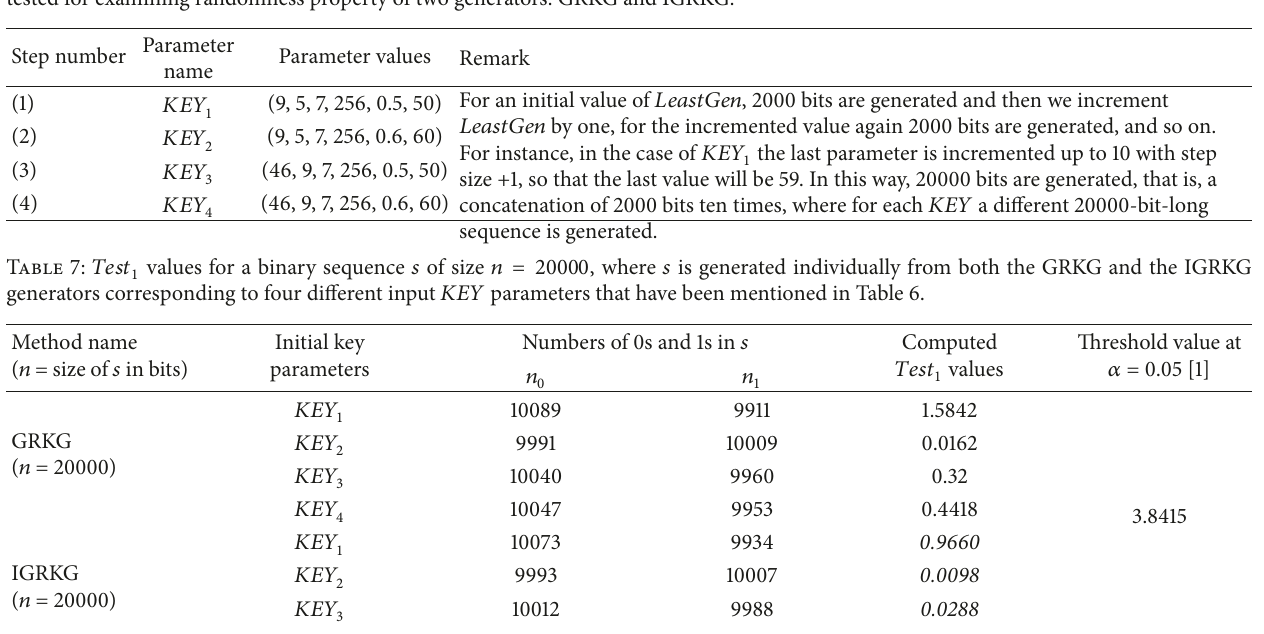
Table 6: Parameter values corresponding to ( 𝑋 −1 , 𝑚 , 𝑐 , 𝑀 , 𝑃 𝑐𝑚 , 𝐿𝑒𝑎𝑠𝑡𝐺𝑒𝑛 ) for generating four different 20000-bit binary sequences to be tested for examining randomness property of two generators: GRKG and IGRKG.